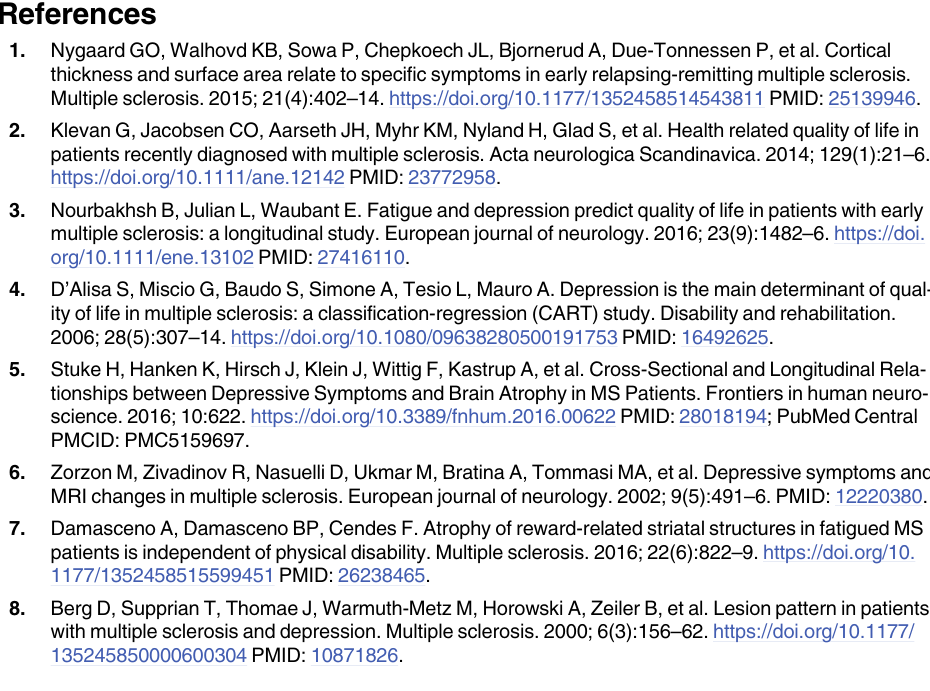
S2 Table. Regional brain volumes increased in clinically isolated syndrome compared to controls. S3 Table. Regional lesion load volumes in clinically isolated